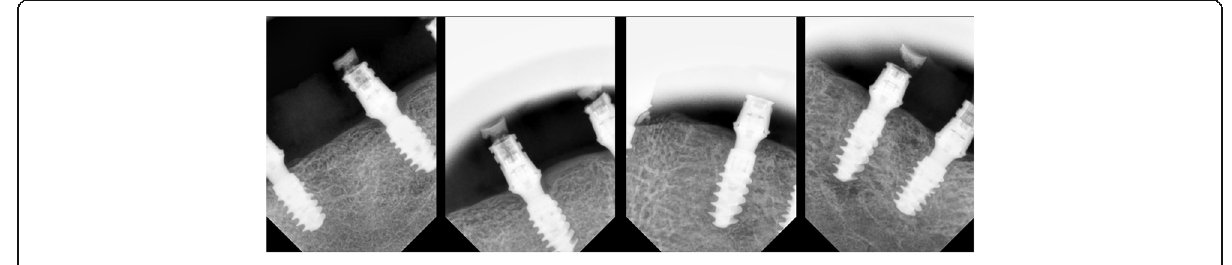
Fig. 16 Periapical X-rays at 1 year